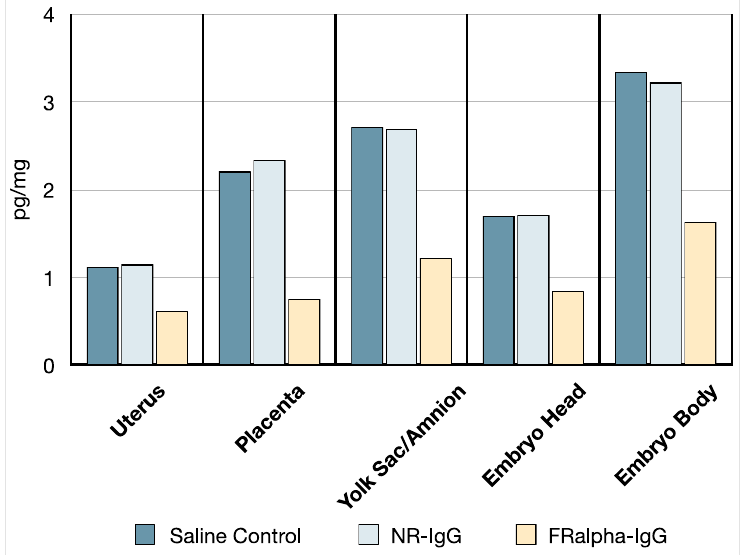
Figure 6. Effect of FR α antibodies on tissue distribution of 3 H-PGA in GD 14 dams following IP injection of antibody and 3 H-PGA. The sample sizes for the placenta and embryo in the saline, control NR-IgG, and FR α Ab groups were n = 3, n = 2, and n = 2, respectively.